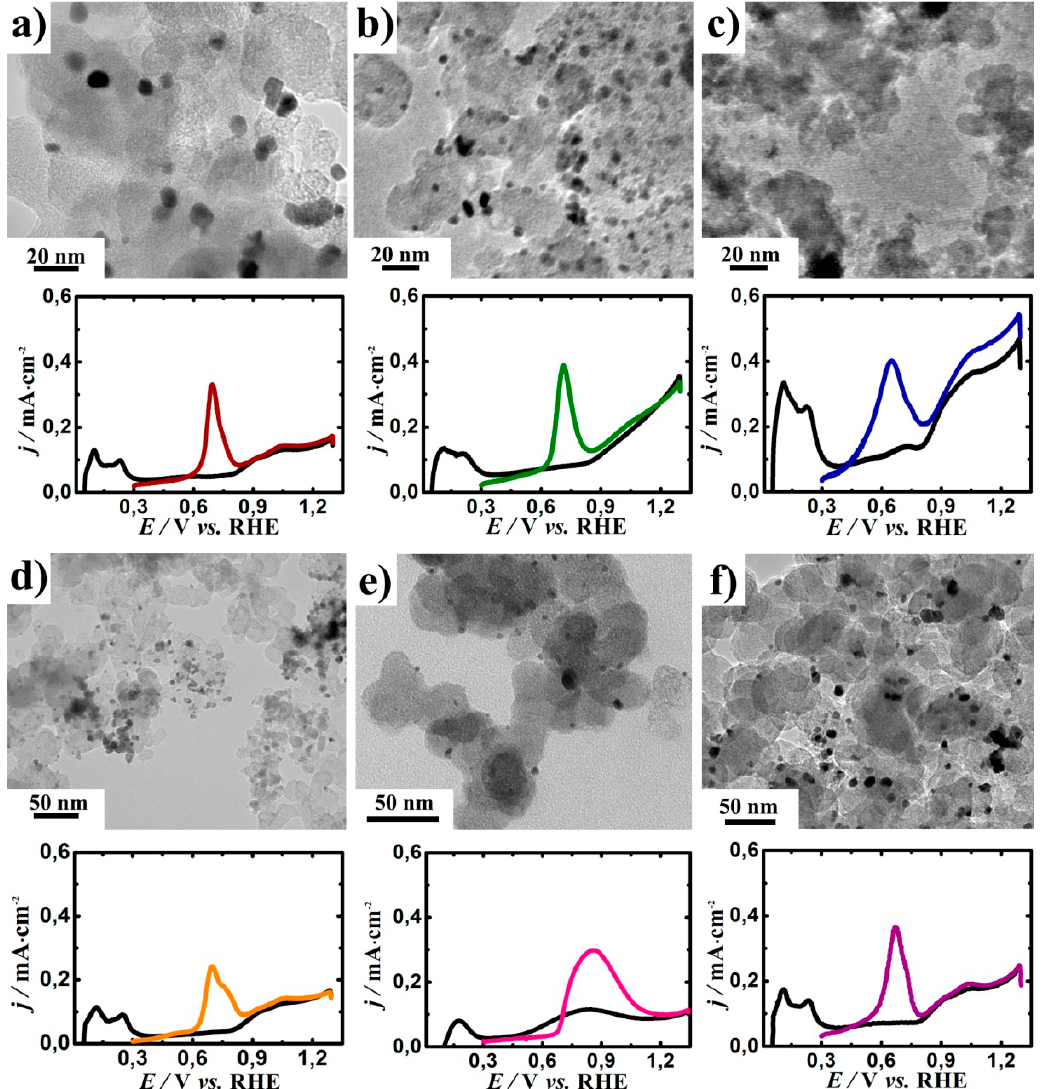
Figure 2. Transmission electron microscopy images and anodic scan of cyclic voltamperograms of ( a ) Pt/C; ( b ) PtNiO/C; ( c ) PtSnO 2 /C; ( d ) PtTiO 2 /C; ( e ) PtRh/C; and ( f ) PtIr/C catalysts in 0.5 M H 2 SO 4 in